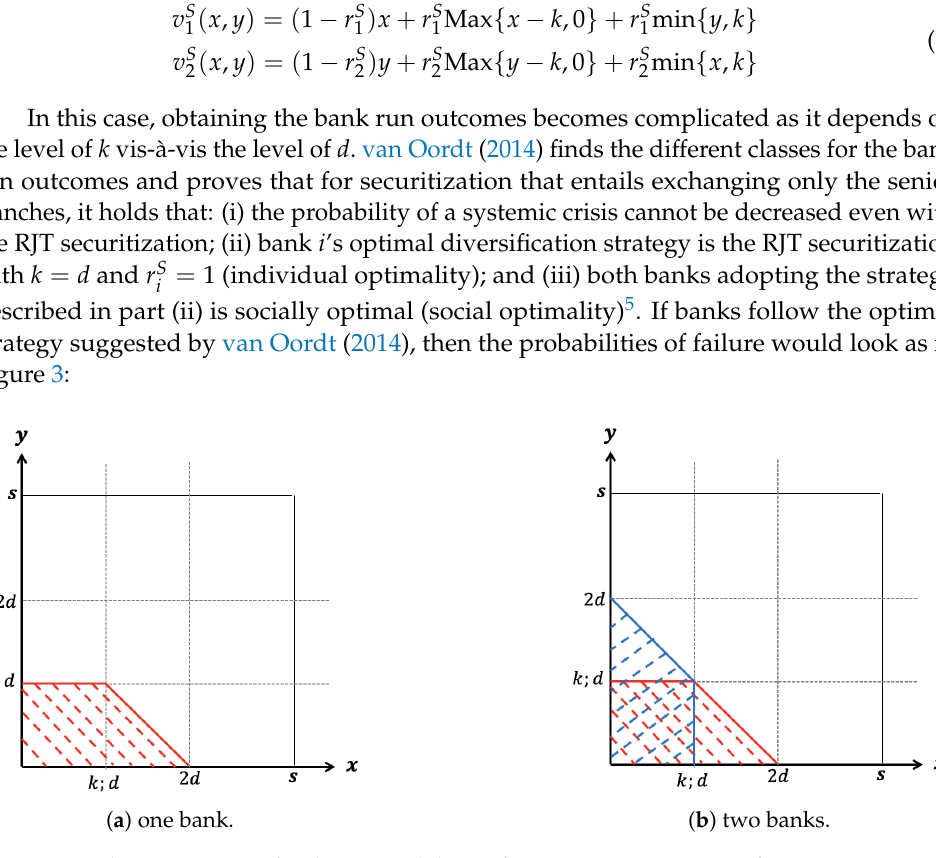
Figure 3. Bank run outcomes for the optimal diversification strategy in case of securitization with keeping a senior tranche. ( a ) one bank ( b ) two